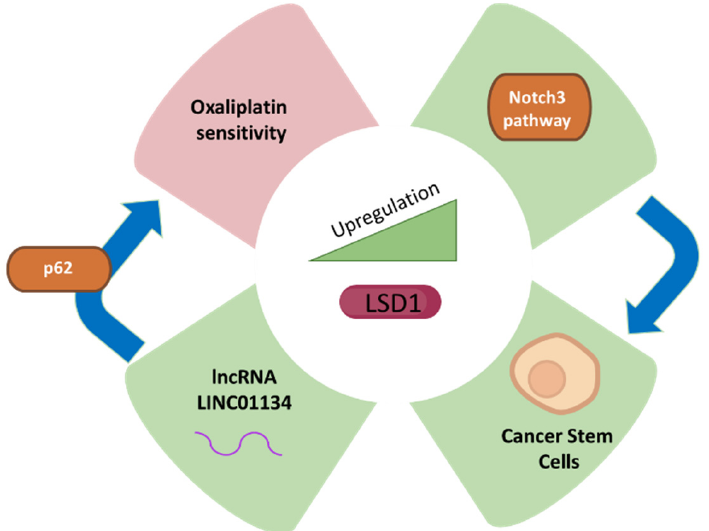
Figure 2. LSD1 expression and its correlation with liver cancer fate. The green colour represents upregulation or increase while purple represents decrease, which are related to LSD1 upregula ‐